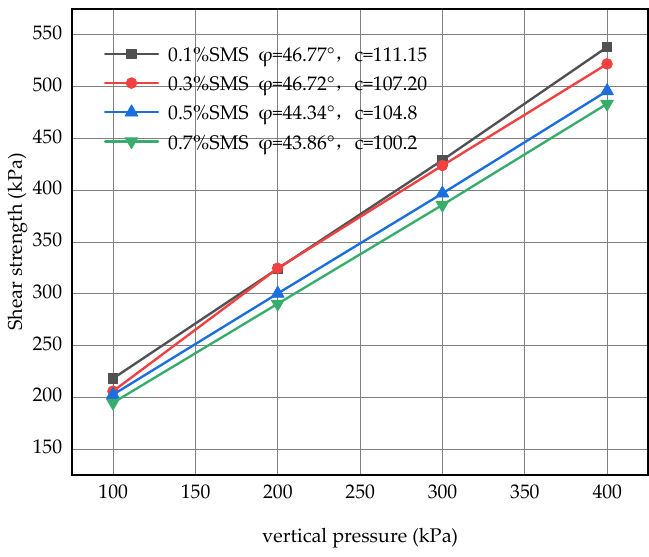
Figure 3. The change of 6% NHL2 shear strength with vertical pressure.